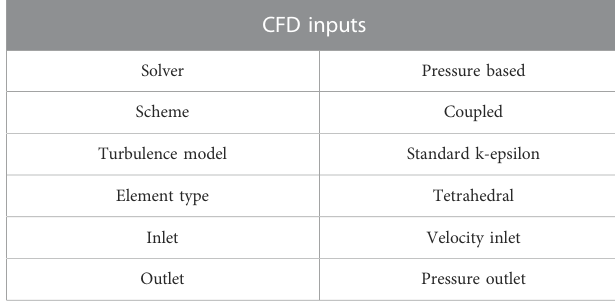
TABLE 3 Important input parameters involved in CFD